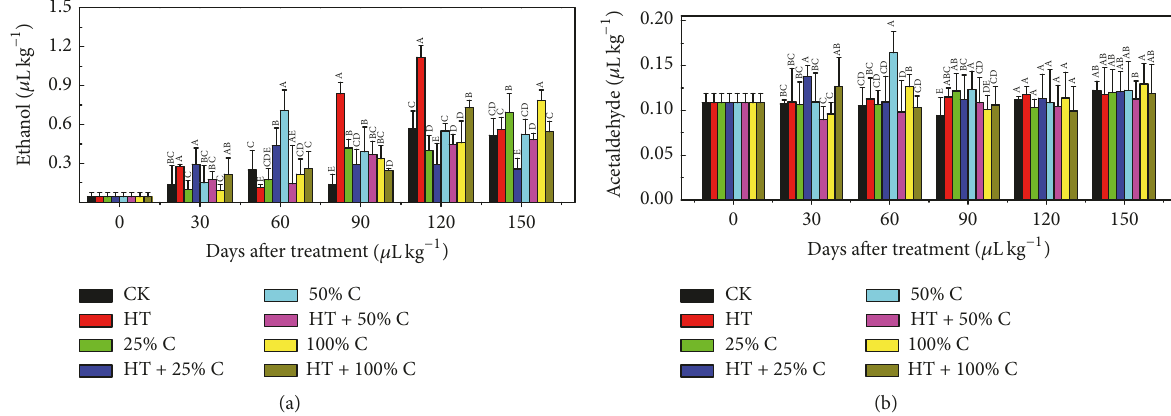
Figure 3: Effects of combined heat and preservative treatments on ethanol (a) and acetaldehyde (b) contents in the fruit pulp during storage. “C” represents the concentration of preservative used in production. The error bars represent the standard errors. Different superscripts between columns represent significant differences between samples at the 0.05